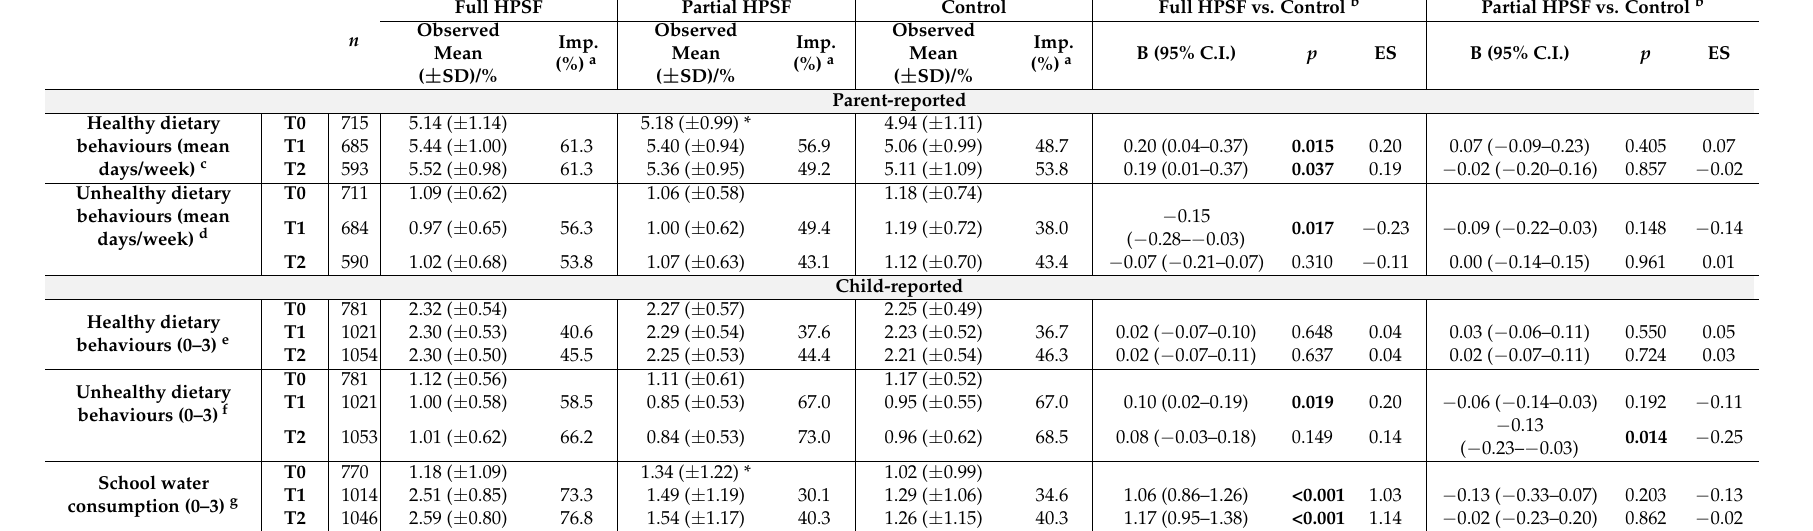
Table 2. Children’s dietary behaviours: Observed descriptives and estimated 1- and 2-year